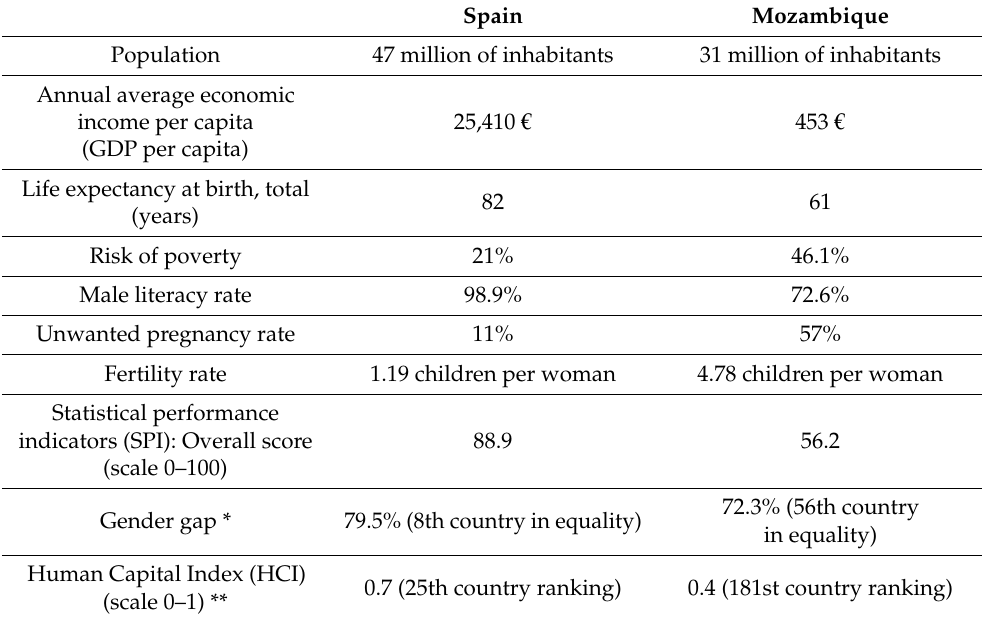
* Gender gap: Measures the size of the gap of said gender inequality in participation in the economy and the qualified world of work, in politics, access to education and life expectancy. ** Human Capital Index: Takes into account three variables: long and healthy life, knowledge, and decent standard of living (United